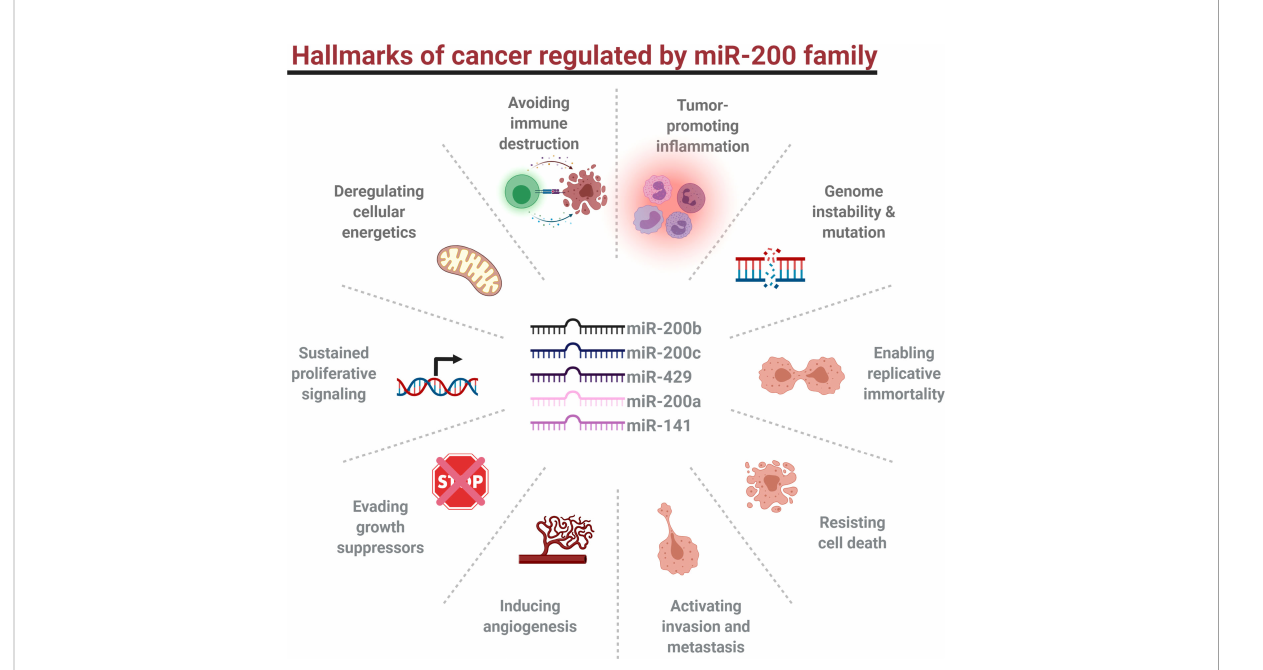
FIGURE 2 Hallmarks of cancer regulated by miR-200 family